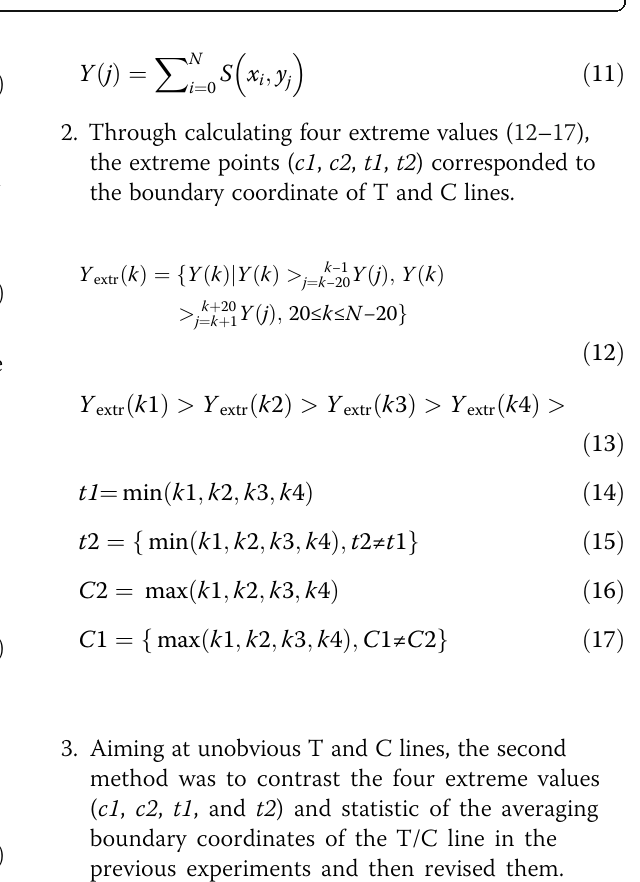
(See figure on previous page.) Fig. 5 a Comparison of three time-consuming algorithms (Sobel algorithm, improved Sobel convolution operator, and Hough transformation). b Binarization images through five algorithms (improved Sobel convolution operator algorithm, Sobel algorithm, Prewitt algorithm, Log algorithm, and Roberts algorithm). c , d The smartphone screenshots which displayed the boundary coordinates. c Two methods for obtaining the left and right coordinates ( left _x and right _x the same as the ic and id ). d The coordinates of the test line and control line (T_line_y1, T_line_y2, C_line_y1 and C_line_y2 same as the t1, t2, c1 and c2). The paint software was developed by our research group in android operating